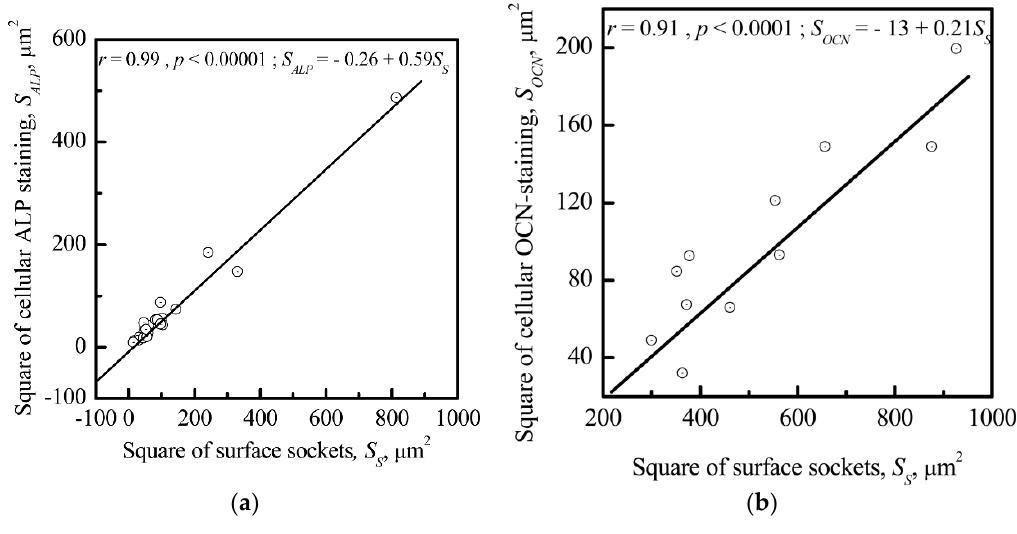
Figure 10. Correlations between the areas containing ALP-stained ( a ) S ALP or OCN-stained ( b ) S OCN . HLPSCs and the surrounding sockets ( S S ) of the CP surface.